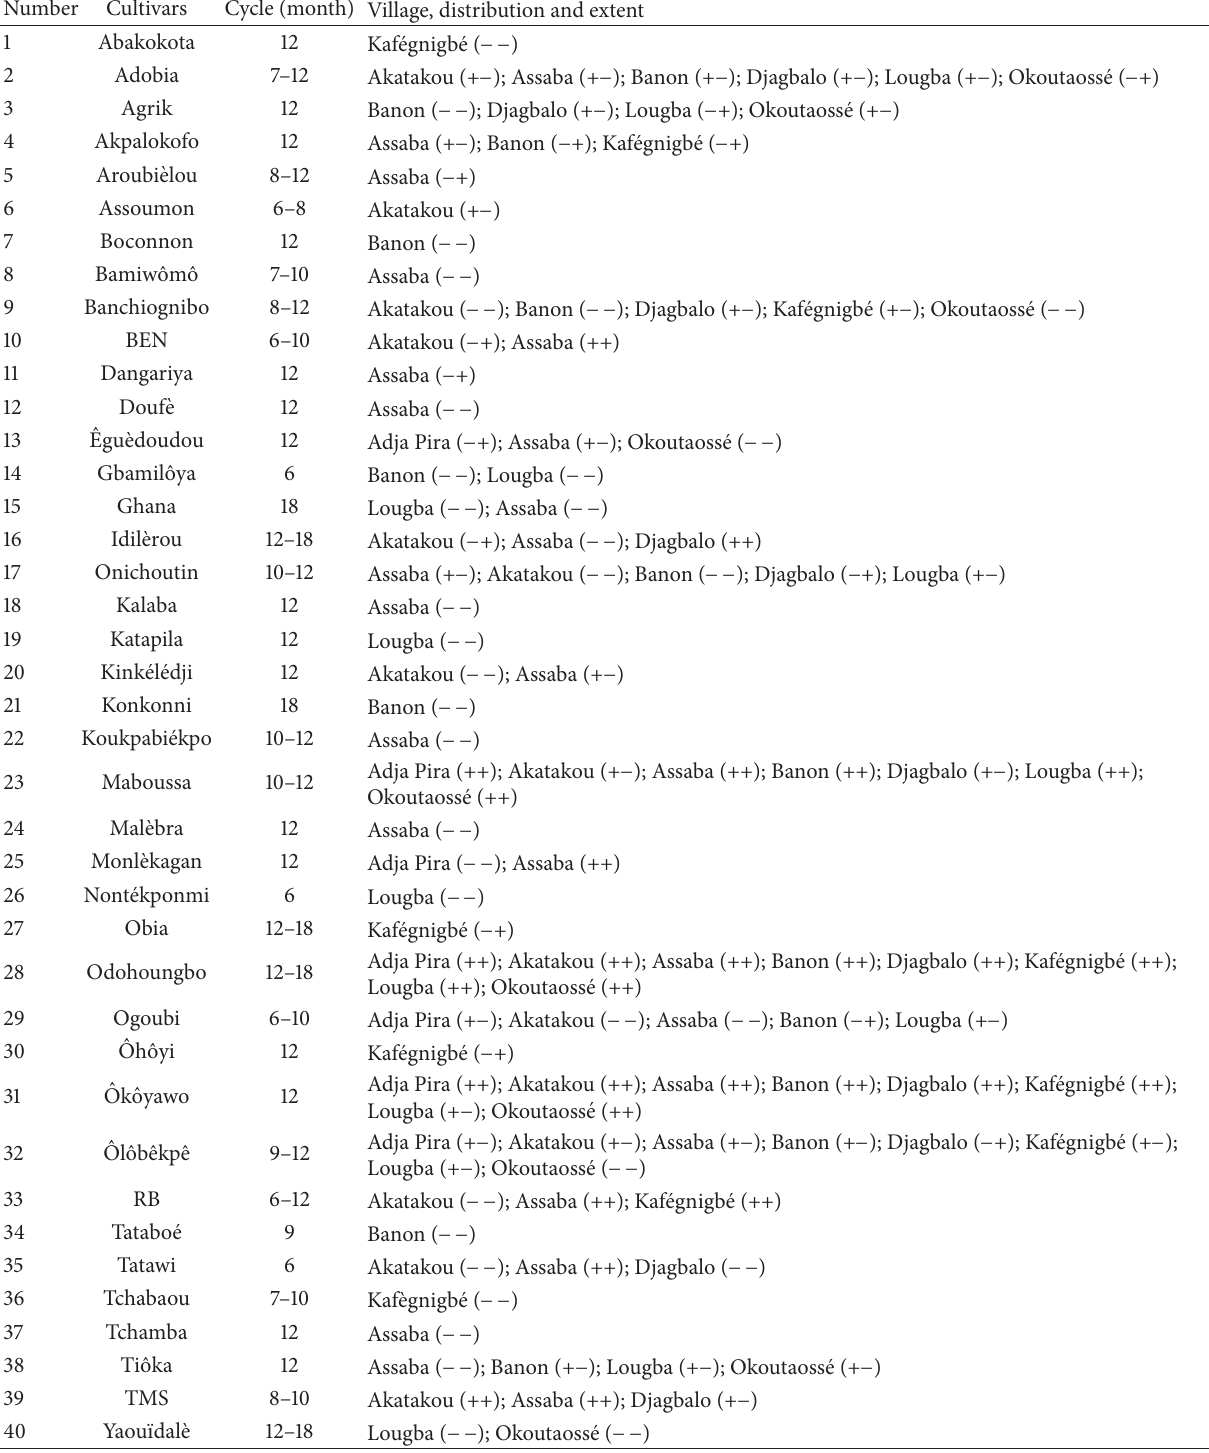
Table 1: Diversity, distribution, and extent of cassava cultivars in Bant`e